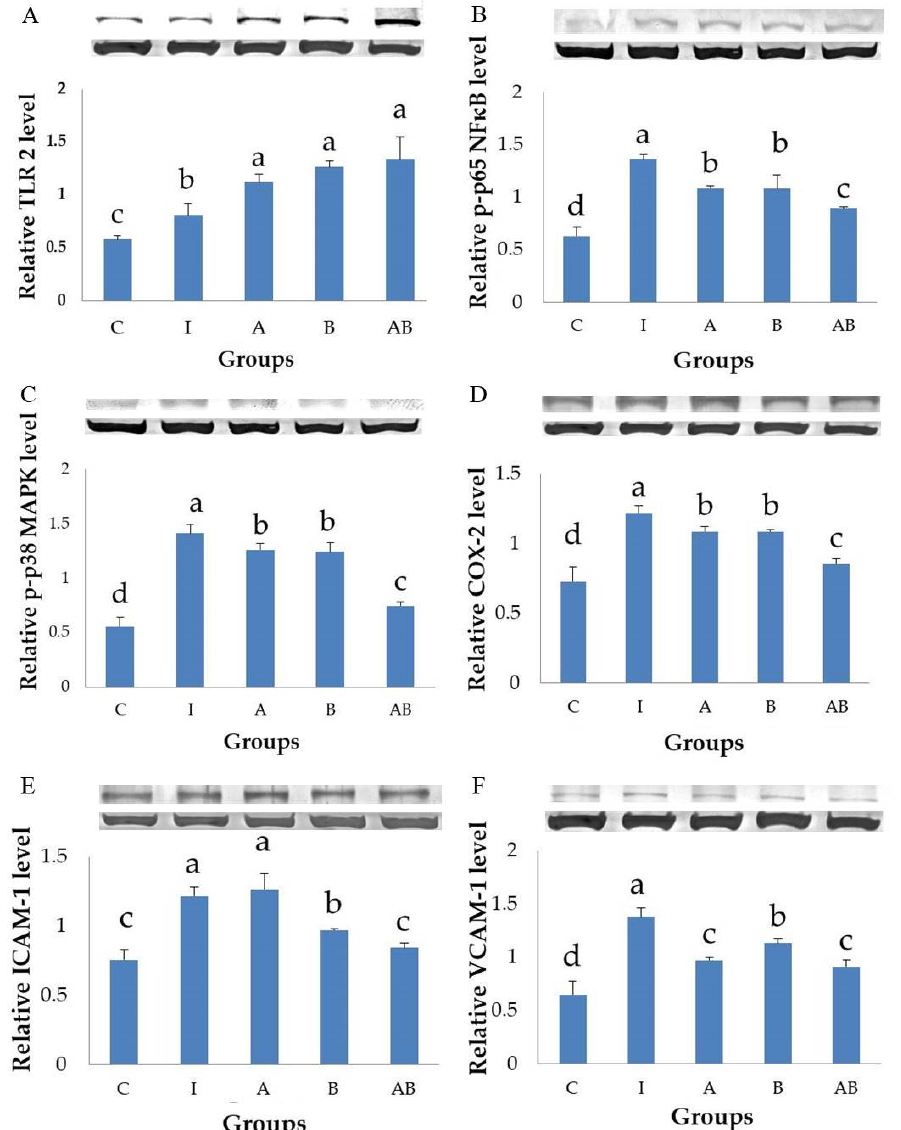
Figure 4. E ff ects of probiotics on the expression of inflammation-related proteins in inflammatory HT-29 cells. All values are mean ± SD (n = 3). Bars with the same letter are not significantly di ff erent from one another determined by Duncan’s multiple range test, p < 0.05. C, control; I, TNF- α (20 ng / mL) with LPS (1 µ g / mL); A, L. acidophilus at MOI of 1 with TNF- α (20 ng / mL) and LPS (1 µ g / mL); B, B. animalis subsp. lactis at MOI of 10 with TNF- α (20 ng / mL) and LPS (1 µ g / mL); AB, L. acidophilus at MOI of 1 and B. animalis subsp. lactis at MOI of 10 with TNF- α (20 ng / mL) and LPS (1 µ g / mL). ( A ), expression of toll-like receptor 2 (TLR2); ( B ), expression of phosphorylated p65 nuclear factor kappa B ( p -p65 NF κ B); ( C ), expression of phosphorylated p38 mitogen-activated protein kinase ( p -p38 MAPK); ( D ), expression of cyclooxygenase-2 (COX-2); ( E ), expression of intercellular adhesion molecule-1 (ICAM-1); ( F ), expression of vascular cell adhesion molecule-1 (VCAM-1).